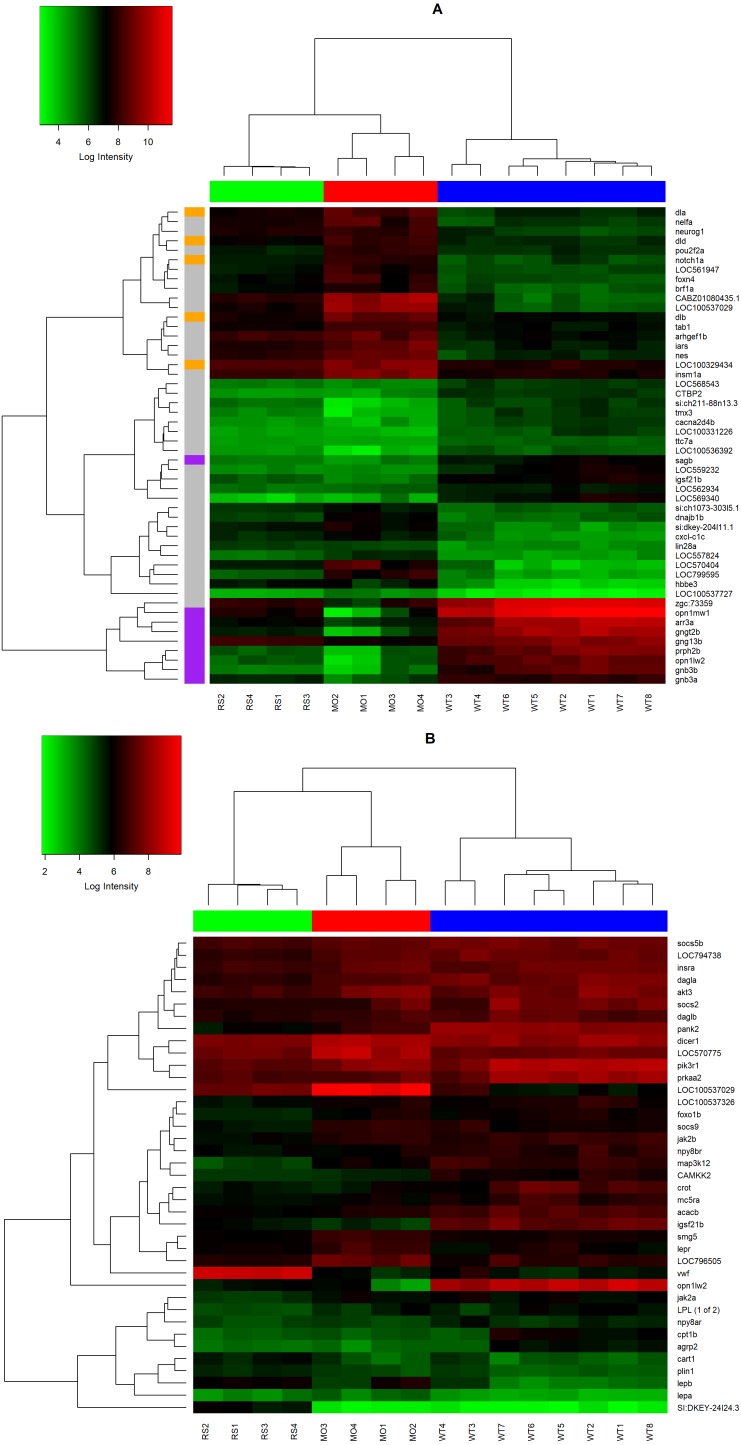
Top-Ranked DEGs (A) and Leptin Signaling DEGs.(A) Heatmap displaying the top-50 ranked DEGs in lepa knockdown compared to controls. Genes (rows) are clustered to represent Delta/Notch genes (orange), Phototransduction (purple), or grey (other). (B) Heatmap containing the zebrafish homologs of leptin signaling genes identified by Park & Ahima (2014), including lepa, lepb, lepr, LOC794738, LOC100537326, akt3, pik3r1, prkaa2, socs2, socs5b, socs9, npy8br, npy8ar, mc5ra, foxo1b, jak2a, jak2b, camkk2, map3k12, agrp2,and cart1. Genes displaying large fold changes (vwf, opn1lw1, igsf21b, LOC100537029), and others that regulate lipid (acacb, dagla, daglb, lpl, crot, plin1, cpt1b, pank2) or RNA metabolism (smg5, dicer1, LOC796505, LOC570775) are also included. Each gene (row) is color coded to represent high (red) and low (green) levels of expression. Columns are color coded by treatment—blue (lepa rescue), red (lepa knockdown), green (uninjected controls).